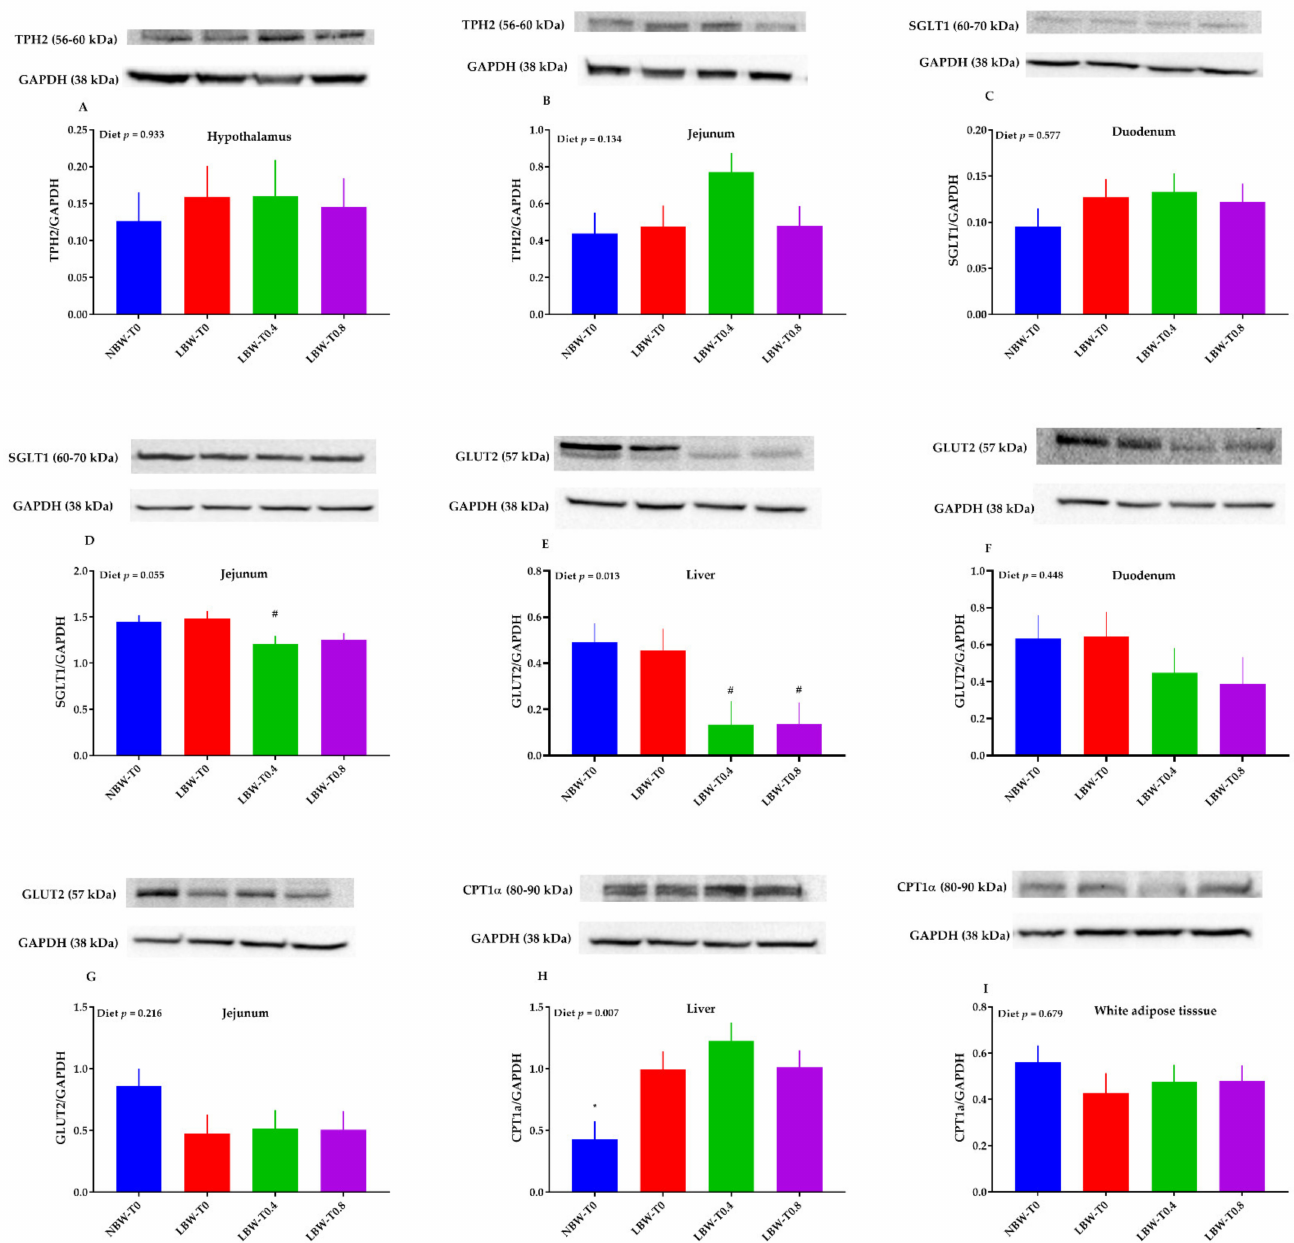
Figure 8. Effect of dietary L-tryptophan supplementation on the relative protein abundance of feed intake and glucose and lipid metabolism markers in the hypothalamus, jejunum, duodenum, liver, and white adipose tissue. ( A ) tryptophan hydroxylase 2 (TPH2) in the hypothalamus, ( B ) TPH2 in the jejunum, ( C ) sodium/glucose cotransporter 1 (SGLT1) in the duodenum, ( D ) SGLT1 in the jejunum, ( E ) glucose transporter-2 (GLUT2) in the liver, ( F ) GLUT2 in the duodenum, ( G ) GLUT2 in the jejunum, ( H ) carnitine palmitoyltransferase I α (CPT1 α ) in the liver, and ( I ) CPT1 α in white adipose tissue. NBW-T0, normal-birthweight piglets fed a basal diet without supplemented L-tryptophan (Trp); LBW-T0, low-birthweight piglets fed a basal diet without supplemented Trp; LBW-T0.4, low-birthweight piglets fed a diet supplemented with 0.4% Trp; and LBW-T0.8, low-birthweight piglets fed a diet supplemented with 0.8% Trp. n = 8 for NBW-T0, LBW-T0, and LBW-T0.8, and n = 7 for LBW-T0.4. * p ≤ 0.05 vs. LBW-T0; # 0.05 < p ≤ 0.1 vs. LBW-T0. The values are the means ±